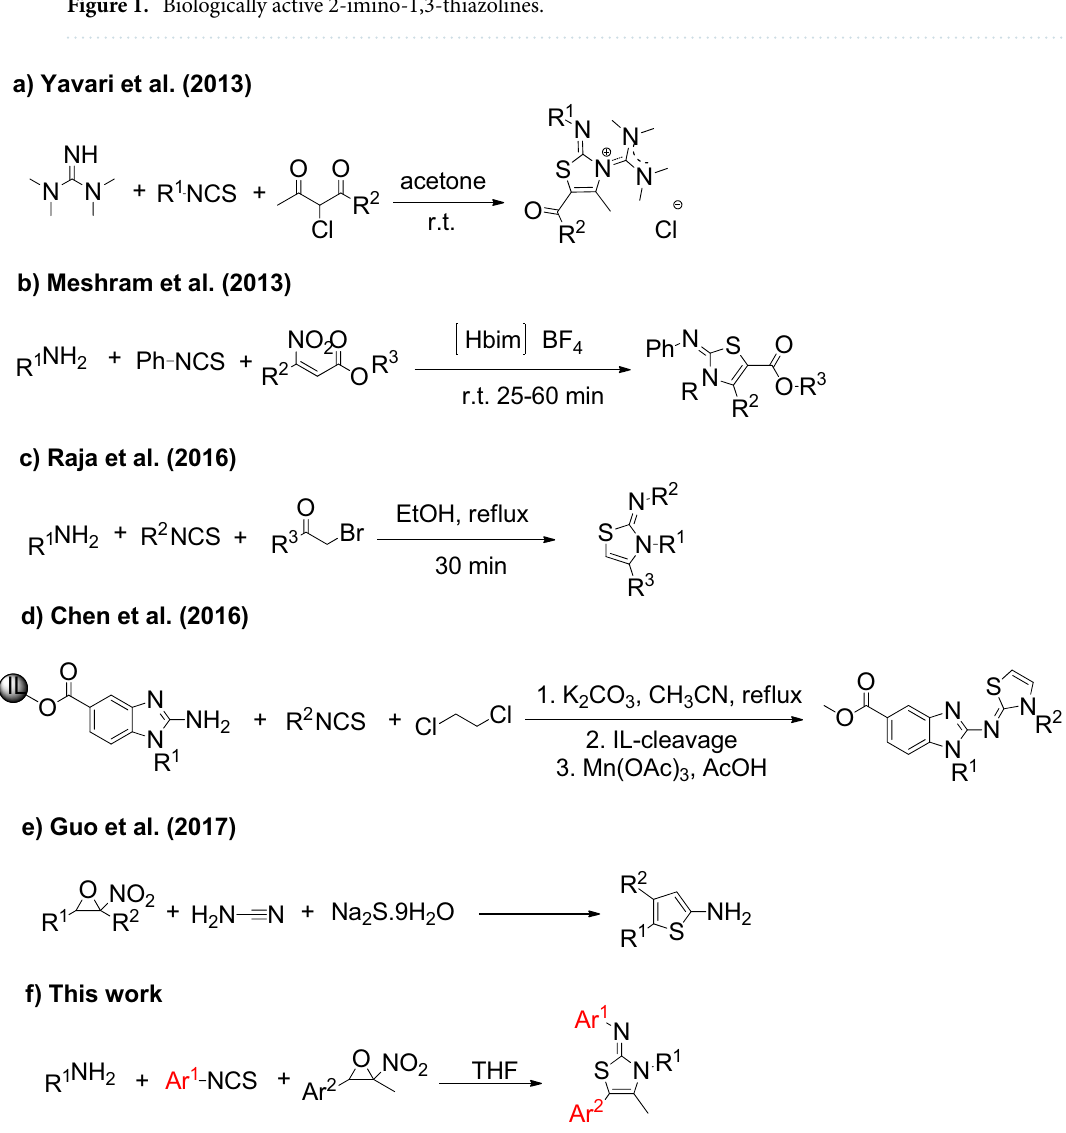
Figure 1. Biologically active 2-imino-1,3-thiazolines.